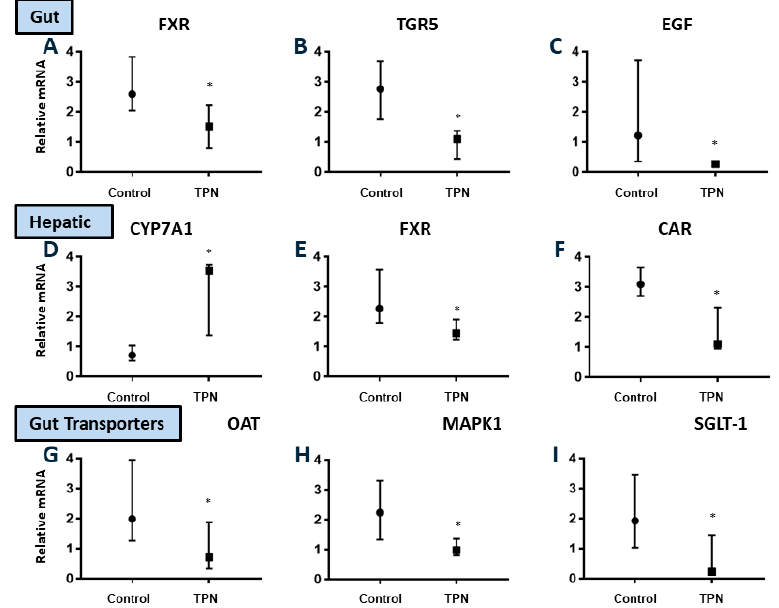
Figure 5. Relative mRNA expression for key bile acid-regulated hepatobiliary receptors and transporters in the gut and liver ( A – I ). Significant downregulation of gut FXR, TGR5, and EGF, as well as hepatic FXR and CAR in TPN animals. Upregulation of hepatic CyP7A1 was found with TPN. There was significant downregulation of gut OAT, Mitogen-activated protein kinases-1 (MAPK1), and SGLT-1 with TPN. The figures show median and interquartile values. Filled circles represent EN and filled boxes represent TPN. A pairwise Mann–Whitney U test was conducted to determine the p -value. All tests were two-sided, using a significance level of